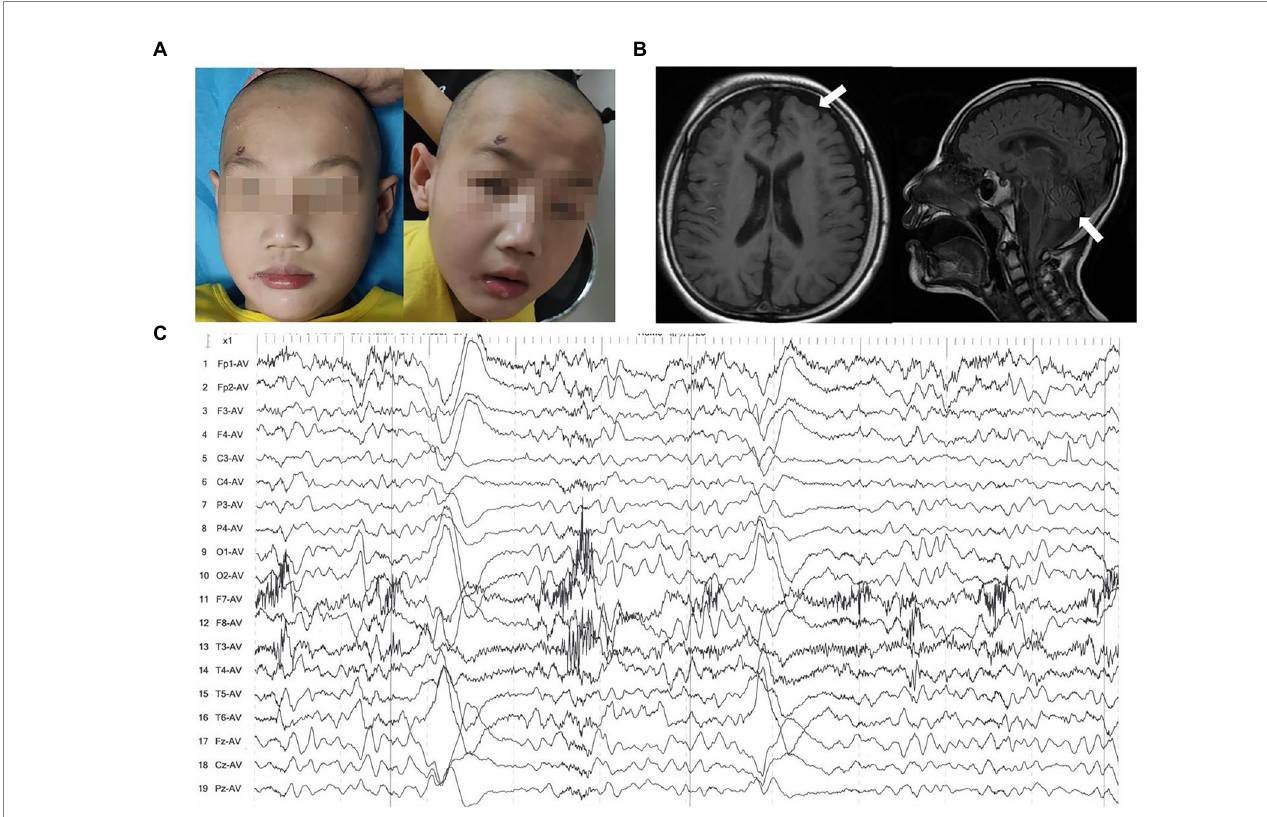
FIGURE 2 Clinical features of patient 2. (A) Images of faces showed microcephaly and wide eye spacing. (B) Brain MRIs performed at the age of 6 years: Axial T1- weighted and sagittal T2-flair images demonstrated enlargement and widening of the cerebral sulcus and cerebral fissure in the bilateral cerebral and cerebellar hemispheres (white arrow). (C) EEG indicated more spikes, slow spikes, multi-spikes, short-range paroxysms, and left–right asynchrony in the contralateral frontal pole and frontal and midline